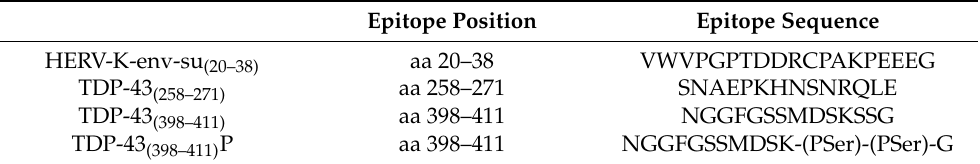
Table 2. Epitopes identified in HERV-K-env-su and